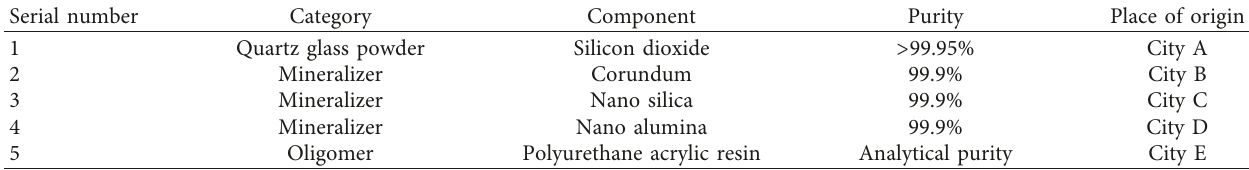
Table 1: Raw materials used in the experiment.